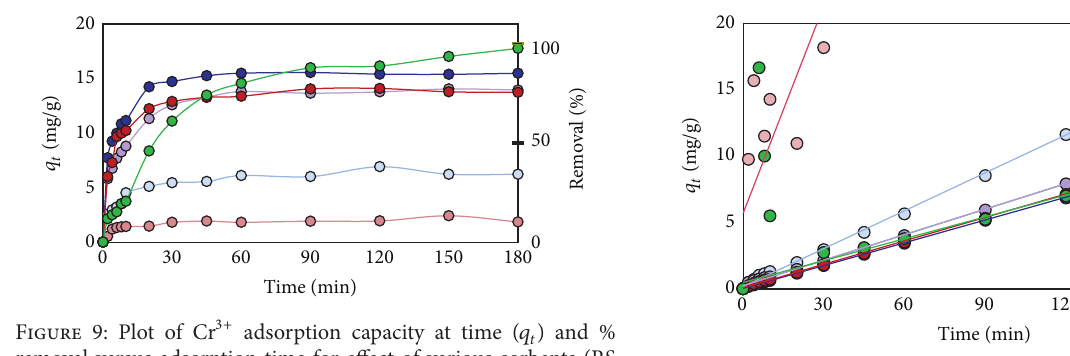
Figure 11: Plot of 𝑡/𝑞 𝑡 of Pb 2+ versus time for effect of different kindsofvariousadsorbents(RS(lightblue),RS-oil3hr(purple),RS- NaOH 450 W (blue), Bagasse (pink), Bagasse-NaOH 600W (red), and Dowax (green)).